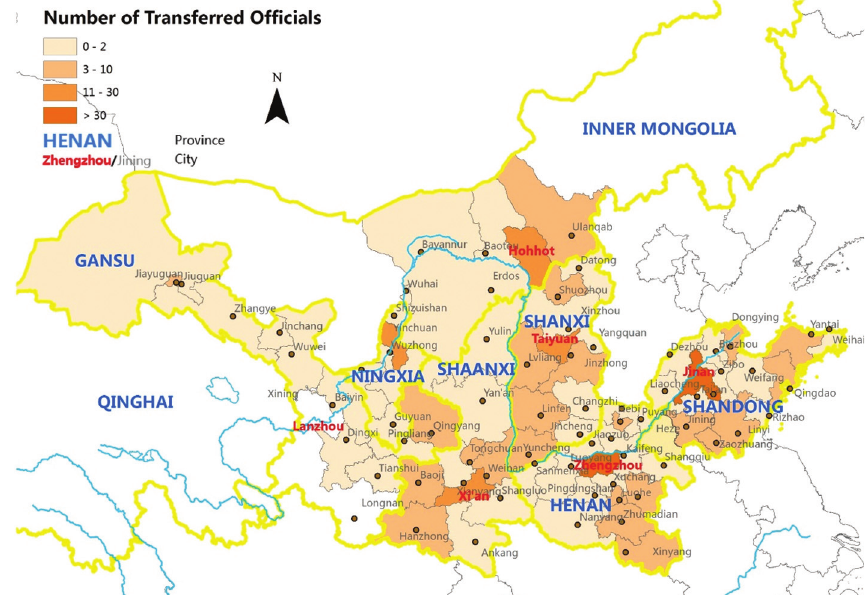
Figure 15: Distribution of the numbers of officials transferred into cities in the Yellow River